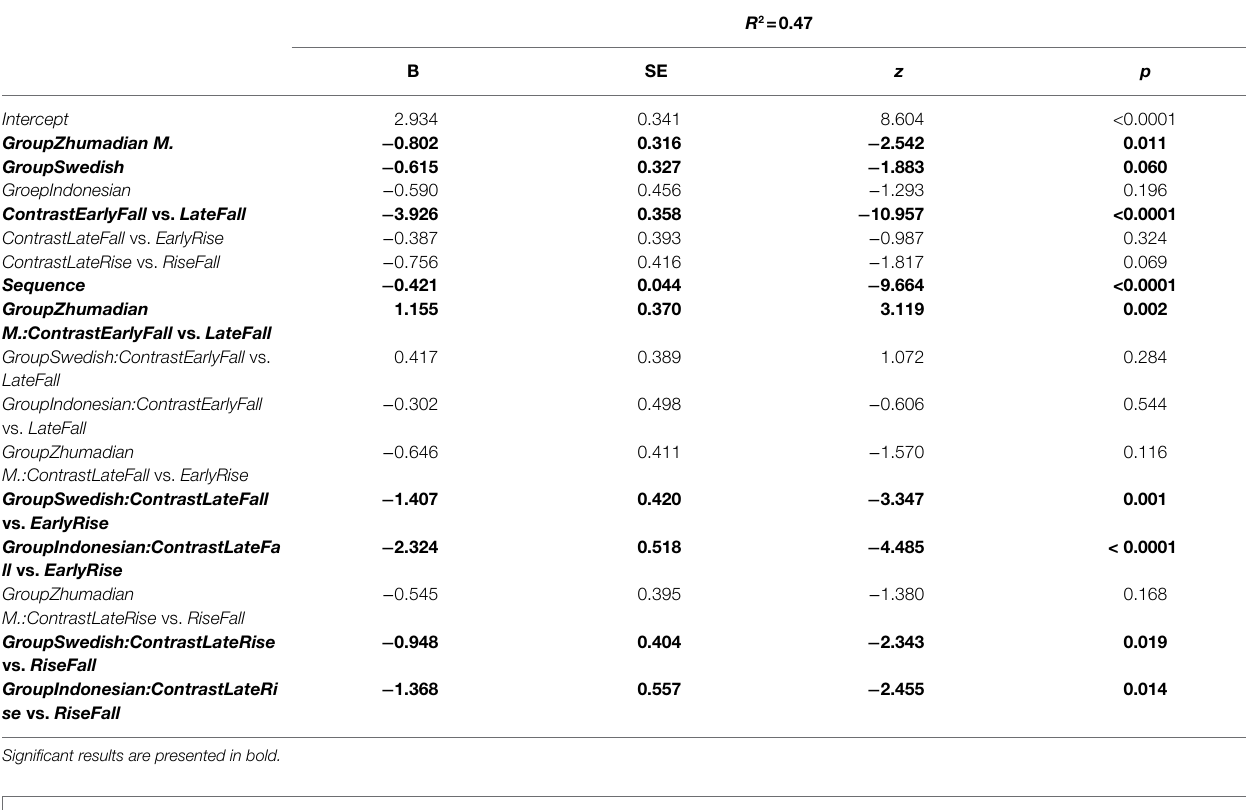
TABLE 8 | Results of mixed-effects logistic regression analysis with Taiwanese Mandarin and [la] vs. [ta] as baselines.